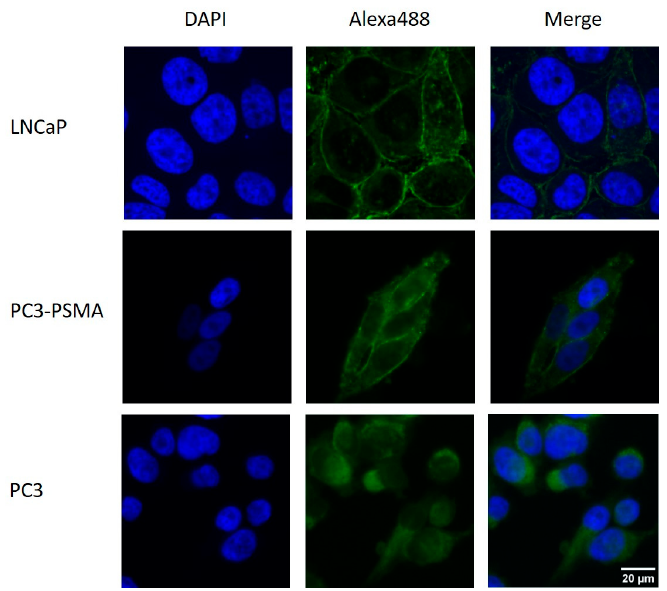
Figure 1. Examples of representative images of PSMA expressions in LNCaP, PC3-PSMA, and PC3 cells. Images are made on AxioObserverZ.1 microscope, 40× magni fi cation.